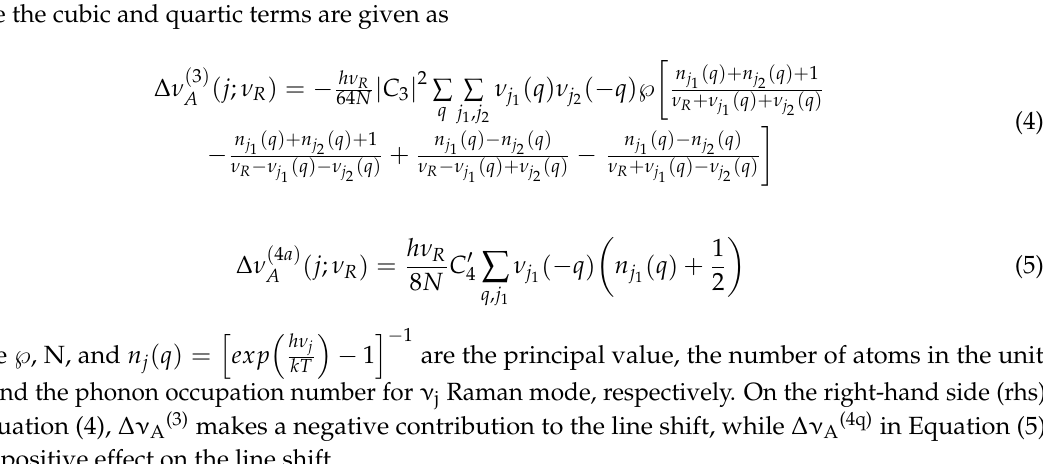
Figure 1. Spontaneous Raman spectrum of SrWO 4 crystal at room temperature.